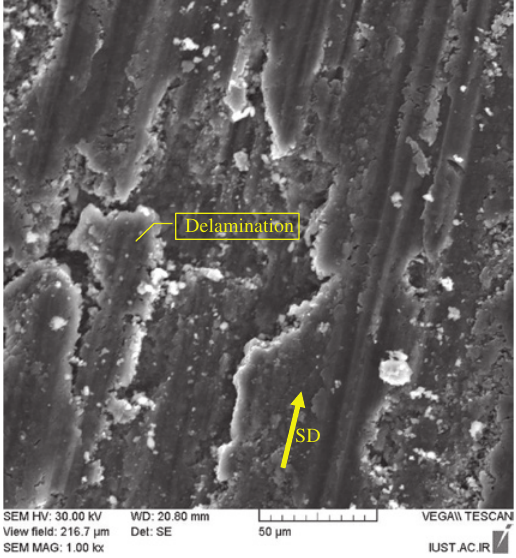
composite at peak p